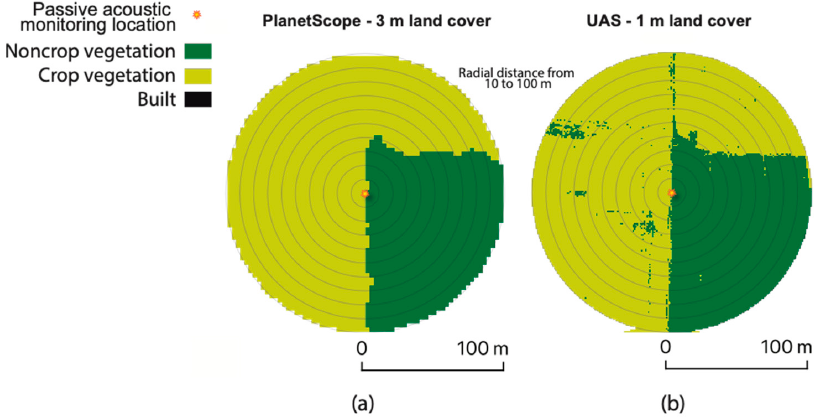
Figure 4. Land cover characteristics from ( a ) PlanetScope (PS) and ( b ) UAS imagery were analyzed within 100 m of the passive acoustic monitoring location.